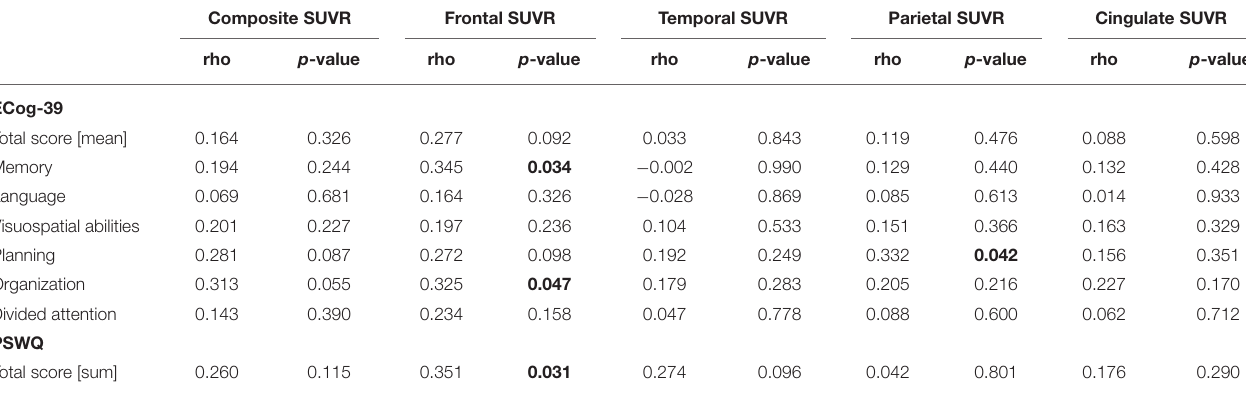
TABLE 2 | Association of amyloid- β load, subjective cognitive complaints, and